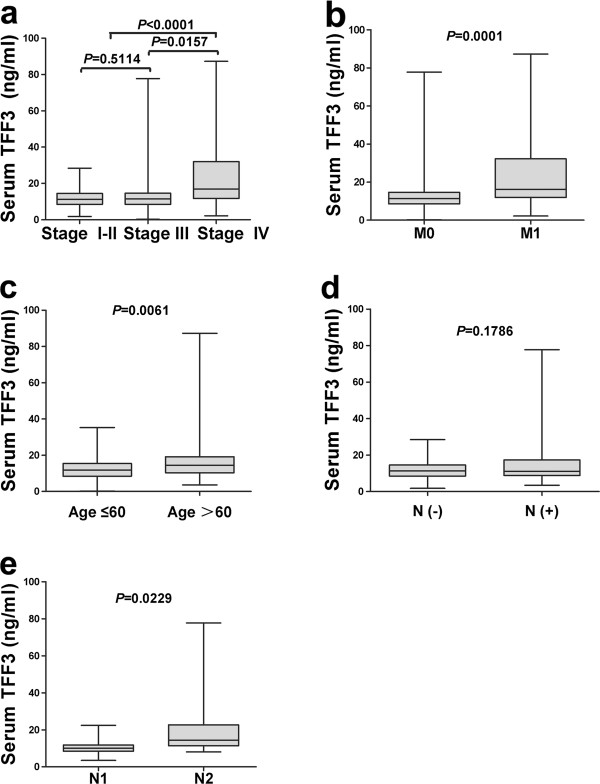
Measurement of serum TFF3 levels in colorectal cancer patients. Serum TFF3 levels were compared in colorectal cancer patients. The significant ratios with P < 0.05 between 2 groups (clinical stage III/IV) and another 2 groups (clinical stage I-II/IV) (a) The significant ratios with P < 0.05 between 2 groups M0 (patients without distant metastasis) and M1 (patients with distant metastasis) (b), lymphatic metastasis after excluding the interference of distant metastasis (d),The significant ratios with P < 0.05 between 2 groups (age >60 y and age ≤60 y) (c) and another 2 groups (N1 and N2) number of lymphatic metastases (e).